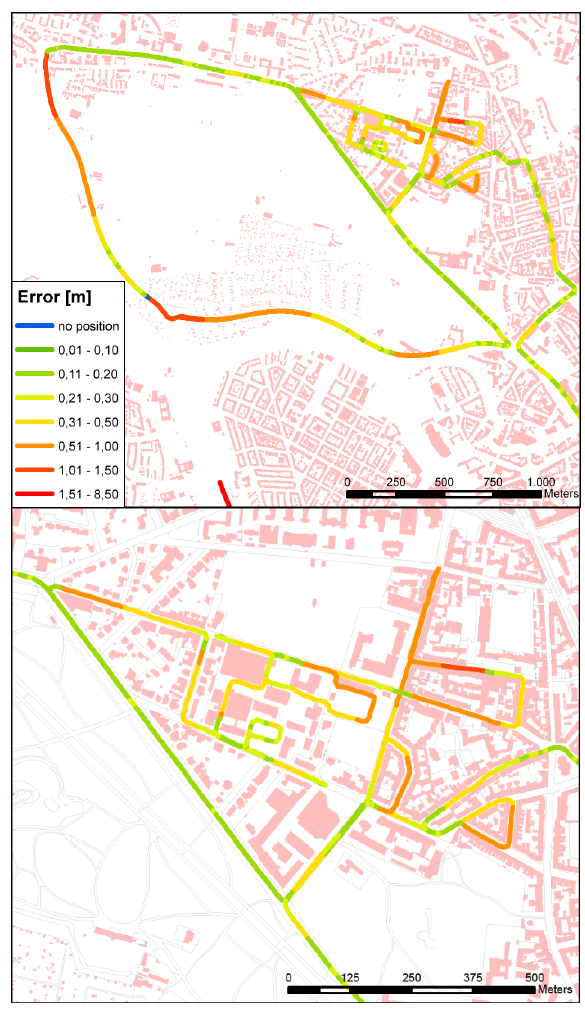
Figure 9. Map of accuracies using an automotive IMU for filtering for a camera system with 100° opening angle. The accuracy along the highway (upper picture, left) depends on the direction of travel (from south to